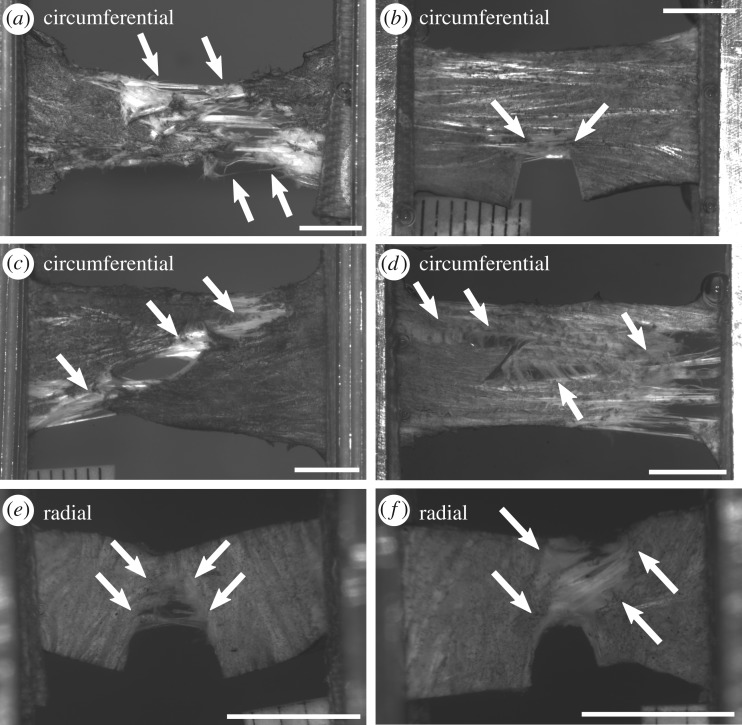
Examples of cracked specimen rupture morphology. (a) Circumferential control specimen, showing a widespread rupture zone and interdigitating fibre pull-out that is typical of circumferential specimen rupture. (b) Circumferential edge crack specimen, showing early rupture at the crack tip combined with crack blunting by inter-fascicle shear. (c) Circumferential centre crack specimen, showing the typical outcome of independent rupture sites merging with the crack. (d) Circumferential centre crack specimen, showing zigzagging of a rupture across the crack and along fascicle interfaces. (e) Radial edge crack specimen, showing crack growth. (f) Radial edge crack specimen, showing simultaneous rupture across its entire width. (a–f) Scale bar, 5 mm.